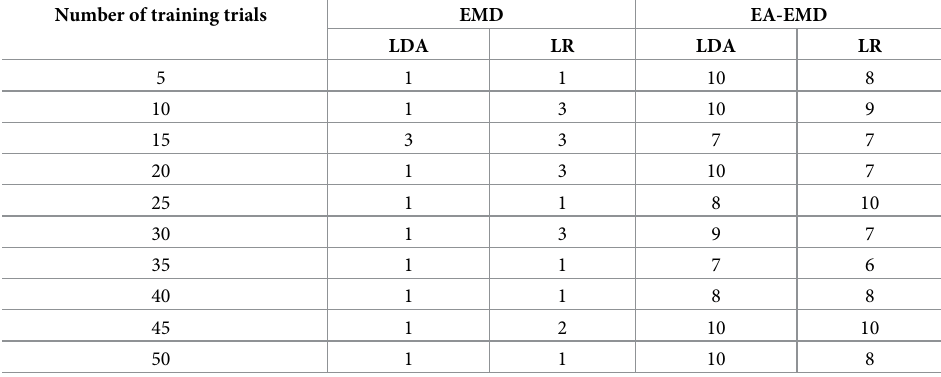
Table 4. Best multiples of artificial frames yielded by EMD and EA-EMD at each number of training trials for dataset